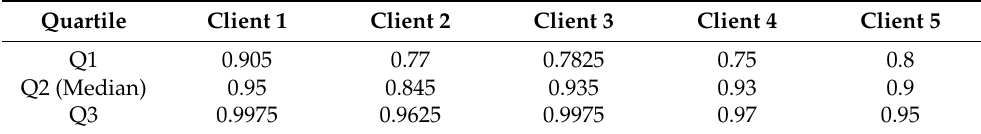
Table 3. Insurance company’s clients’ quartiles.